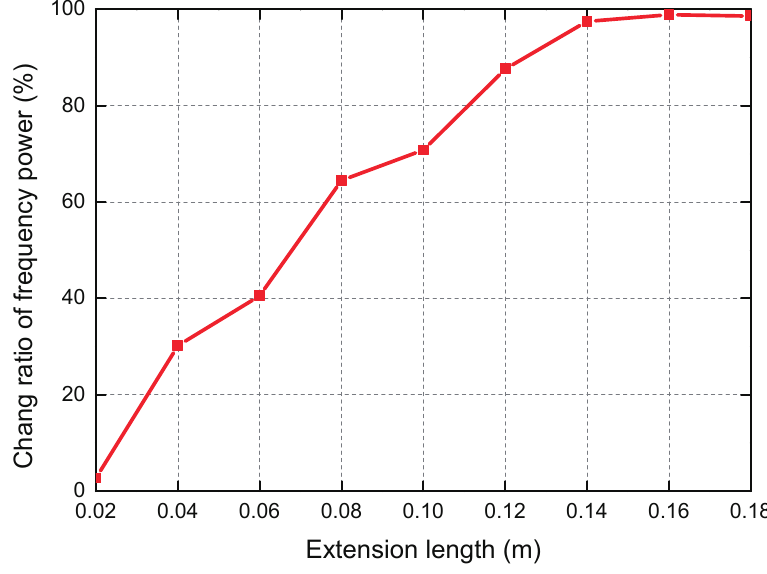
Figure 15. Different hand extension